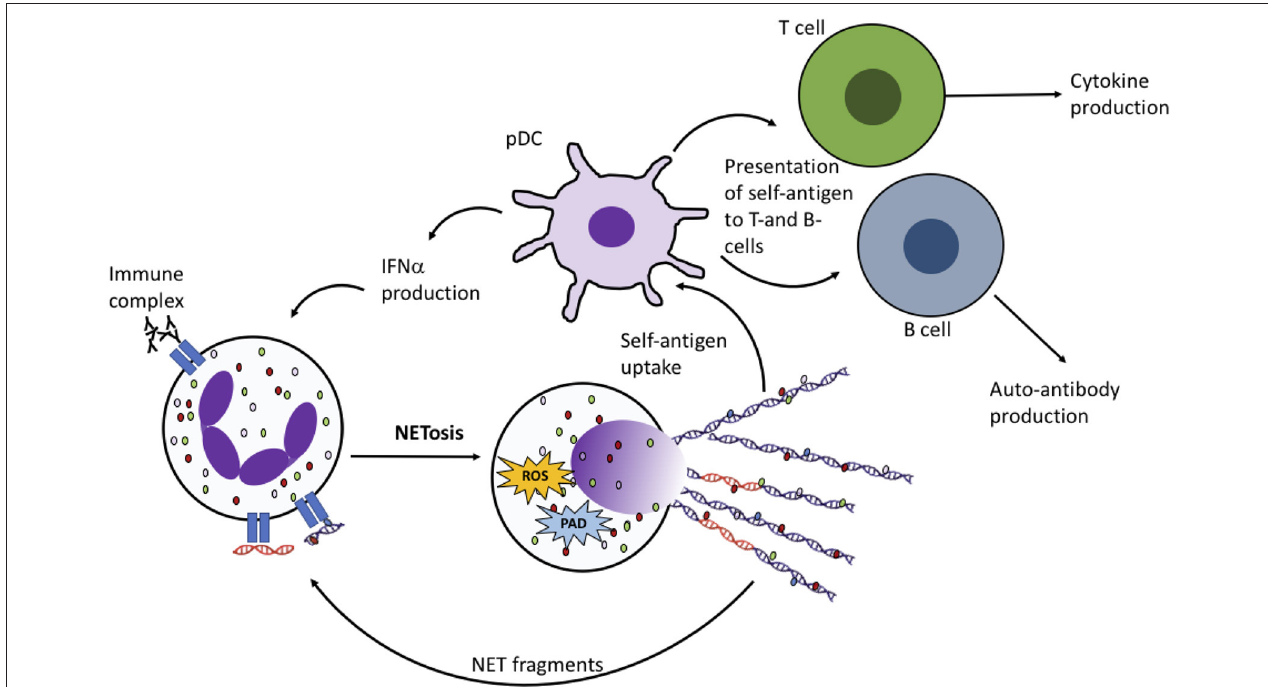
FIGURE 3 | NET production in RA and SLE drives the auto-immune response. Fragments of DNA and proteins (including histones, MPO, elastase, HMGB1, LL37) are taken up by plasmacytoid dendritic cells (pDCs) and presented to auto-reactive B- and T-cells, leading to production of cytokines including interferon alpha (IFN α ) and autoantibodies. NET fragments, including oxidized DNA (shown in orange) may also activate NET production by neighboring